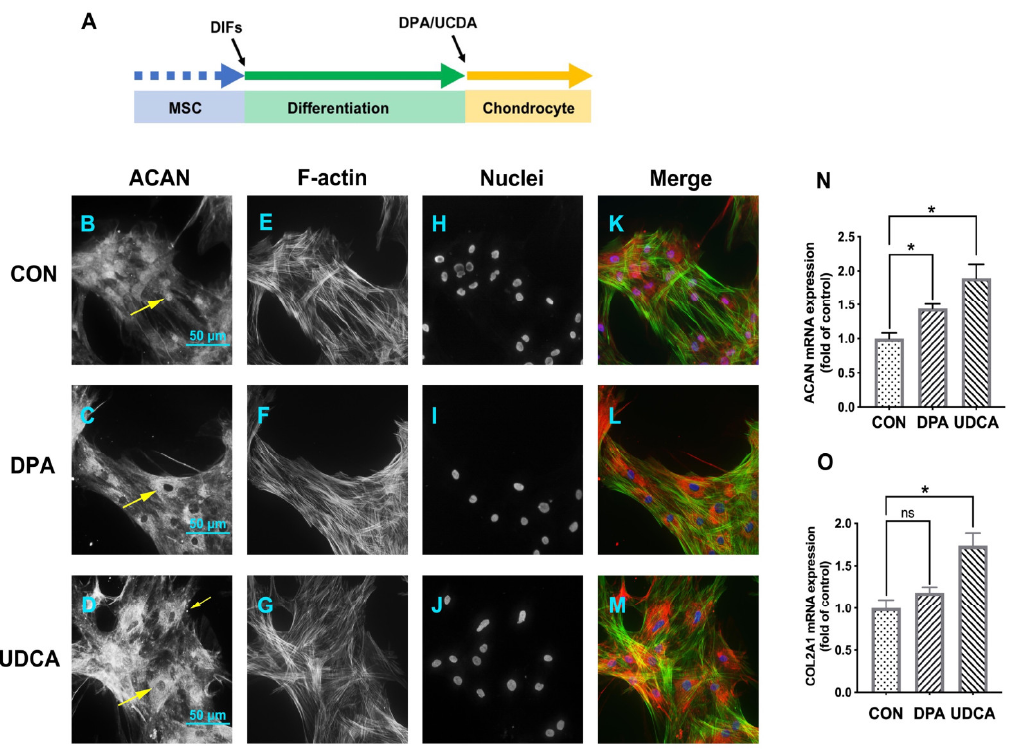
Figure 5. The effects of DPA and UDCA on chondrocyte functionality. DPA or UDCA was added to the chondrocytes for five days before sampling ( A ). The distribution of ACAN (red); the distribution of F-actin (green) and nuclei (blue), counterstained with phalloidin and DAPI, respectively. The immuno-positive signal of ACAN (arrows) is relatively weak and located in the nucleus and cytoplasm in the CON group ( B , H , K ), while it becomes strong, moves to the cytoplasm, and exhibits external secretion after DPA ( C , I , L ) or UDCA ( D , J , M ) administration. ( E , F , G ) indicate the shape of chondrocyte. The scale bar represents 50 μm. The mRNA expression levels of the ACAN ( N ) and COL2A1 ( O ) in the CON, DPA, and UDCA groups are quantified. The data are presented as mean ± SEM (n = 3). ns indicates no significance ( p > 0.05); * p < 0.05.